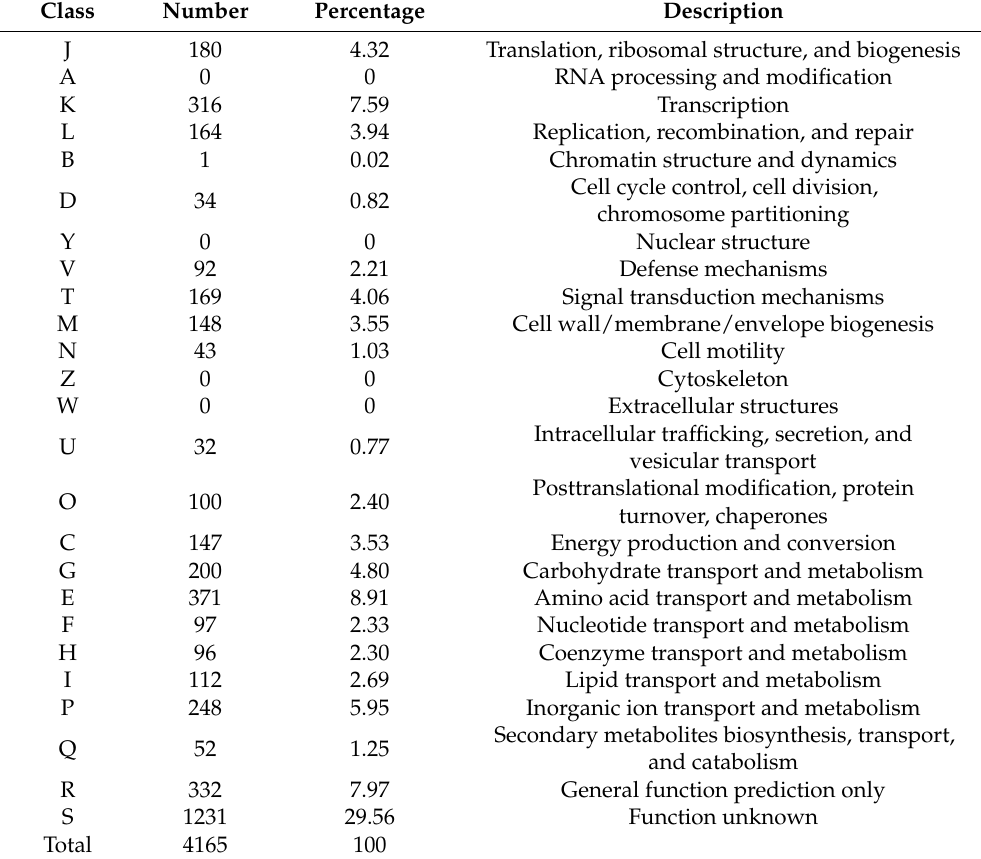
Table 1. Number of genes associated with general Cluster of Orthologous Groups functional categories.